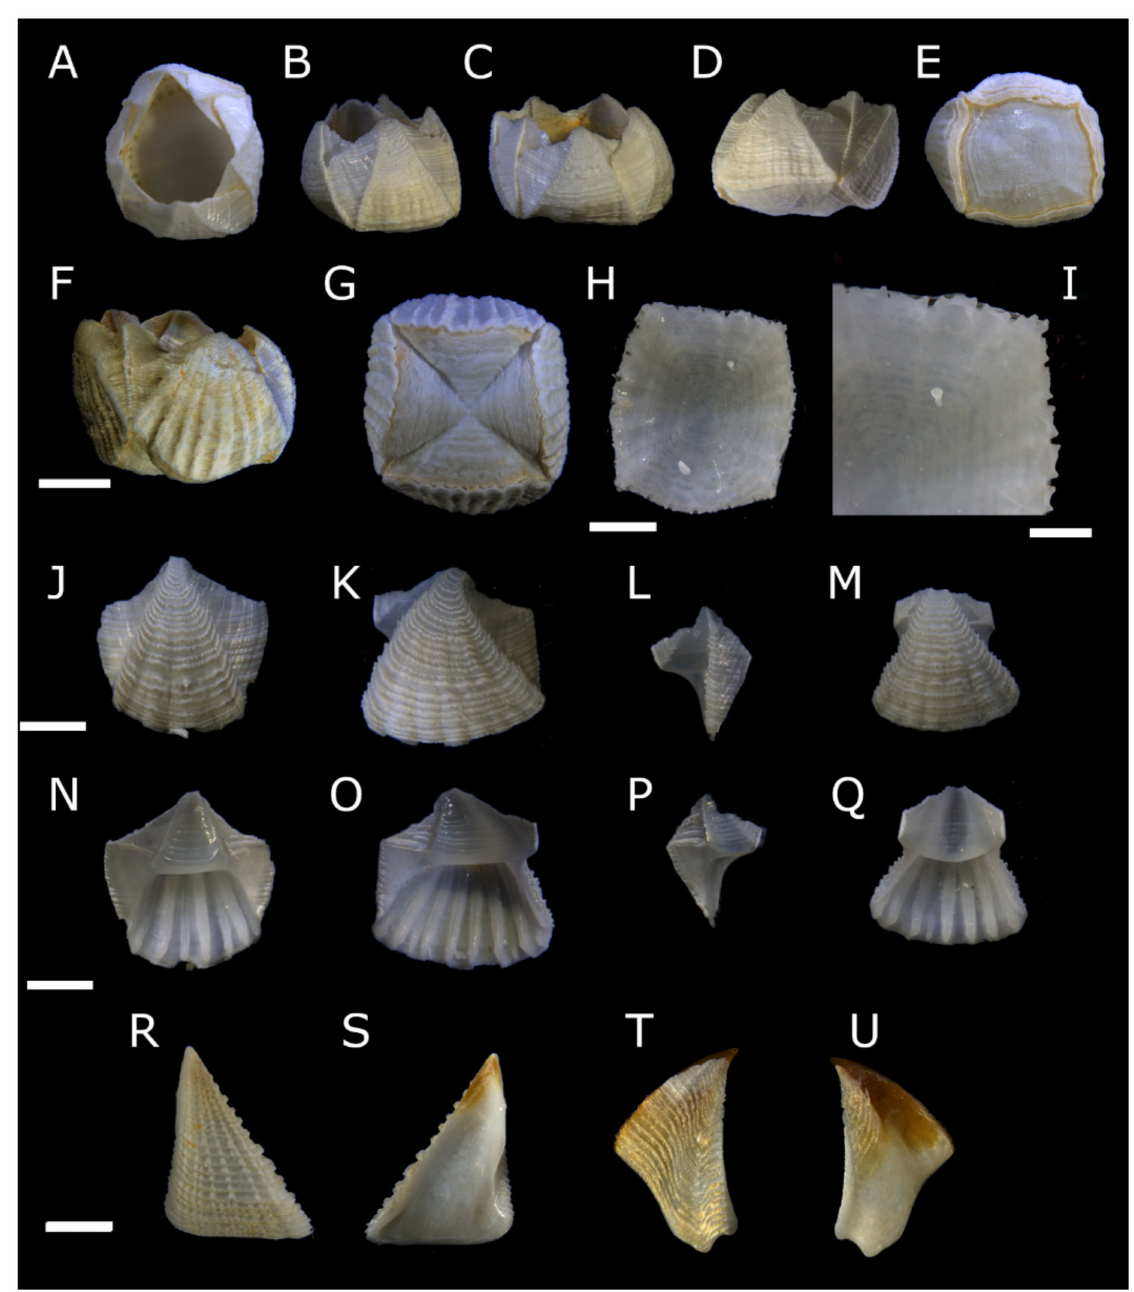
Figure 9. Euacasta acutaflava sp. nov. ( A – E ) top, rostral, left, right and basal views, respectively, of holotype (WAM C58744), opercular plates removed; ( F , G ) left lateral and basal views, respectively, of paratype (WAM C61435), opercular plates removed; ( H ) internal view of basis; ( I ) enlarged portion of basis rim showing crenate margin; ( J – M ) external and ( N – Q ) internal views of rostrum, right lateral, right carinolateral and carina, respectively of paratype (WAM C76451); ( R , S ) external and internal view of scutum; ( T , U ) external and internal view of tergum of holotype (WAM C58744). Scale bars: A–G = 2 mm; H, J–U = 1 mm; I = 0.5